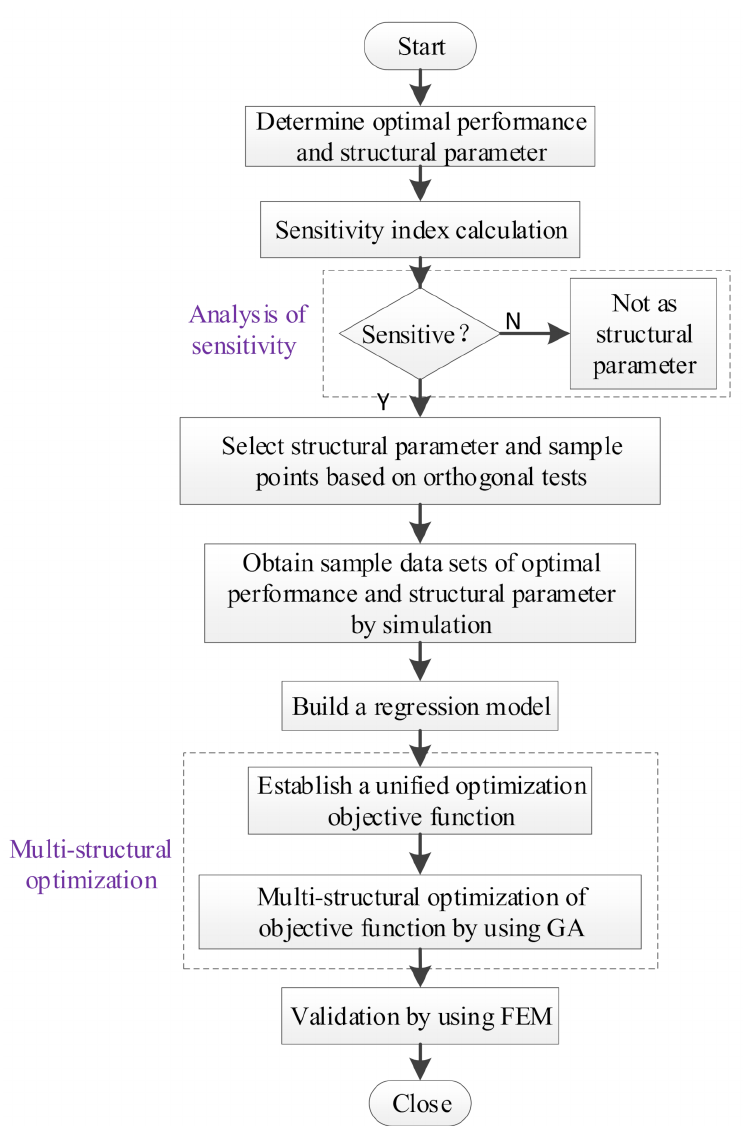
Figure 2. Optimization